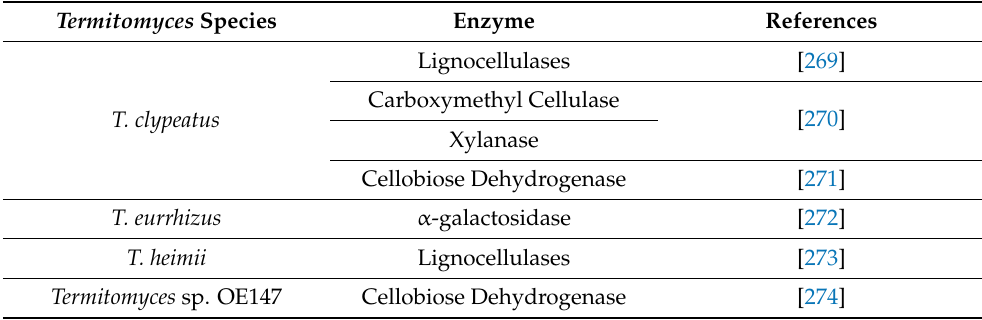
Table 8. Enzyme isolated from different Termitomyces